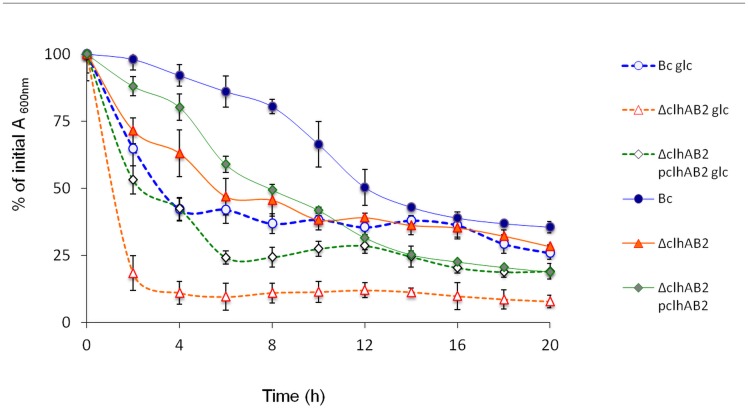
Autolysis of B. cereus wild-type ATCC 14579 (Bc), ΔclhAB2 mutant (Δ), complemented mutant (ΔΩ) strains in PBS buffer.The autolytic rate was expressed as the percentage decrease in the OD610nm. Mean values (SD, n = 4). % of OD values of the ΔclhAB2 are all significant different from Bc between 2 and 20h in LBG and in LB between 6 and 12h. Significance is based on Mann & Whitney test with a P-value of <0.01**. Symbols. Bc (blue circle), Δ clhAB2 (orange triangle) and the ΔclhAB2Ω clhAB2 (green losange).